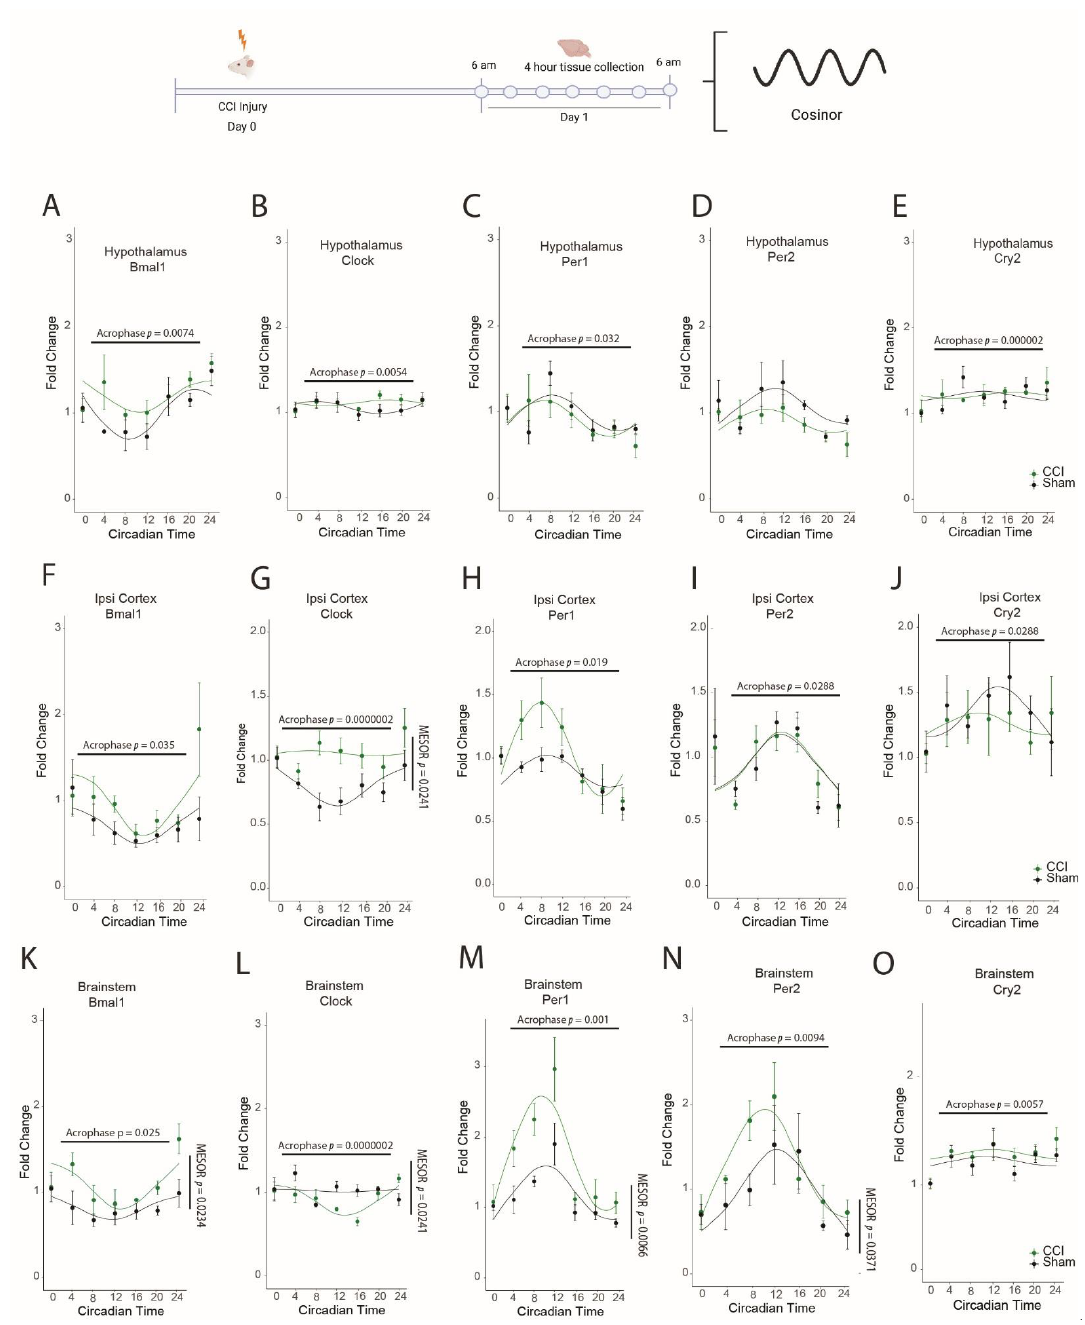
Figure 2. CCI alters diurnal expression of core circadian genes in multiple brain regions. Schematic of the experimental design showing that mice were exposed to CCI or sham surgery. Starting at ZT0 the following day, brain tissue was collected every 4 h for 24 h. In the hypothalamus we quantified ( A ) Bmal1 , ( B ) Clock , ( C ) Per1 , ( D ) Per2 and ( E ) Cry2 . In the ipsilateral cortex we quantified ( F ) Bmal1 , ( G ) Clock , ( H ) Per1 , ( I ) Per2 and ( J ) Cry2 . In the brainstem we quantified ( K ) Bmal1 , ( L ) Clock , ( M ) Per1 , ( N ) Per2 , and ( O ) Cry2 . Changes to MESOR or acrophase are indicated on the individual graphs. Each datapoint represents the mean ± SEM of n =